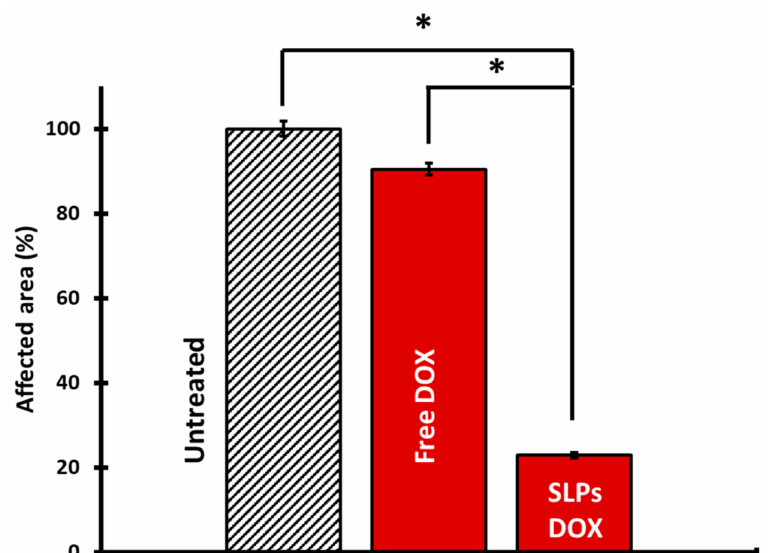
Figure 5. SLPs significantly reduce metastasis in the lungs. Representation of lung metastasis is expressed as the affected area with respect to the total area of the lung. Reduction in metastasis can be observed when the lungs are treated with the SLPs-DOX compared with the lungs treated with the free drug ( t = 5.94; n = 170; * t 0.001 ). These differences are also significant between the lungs treated with SLPs-DOX with respect to untreated